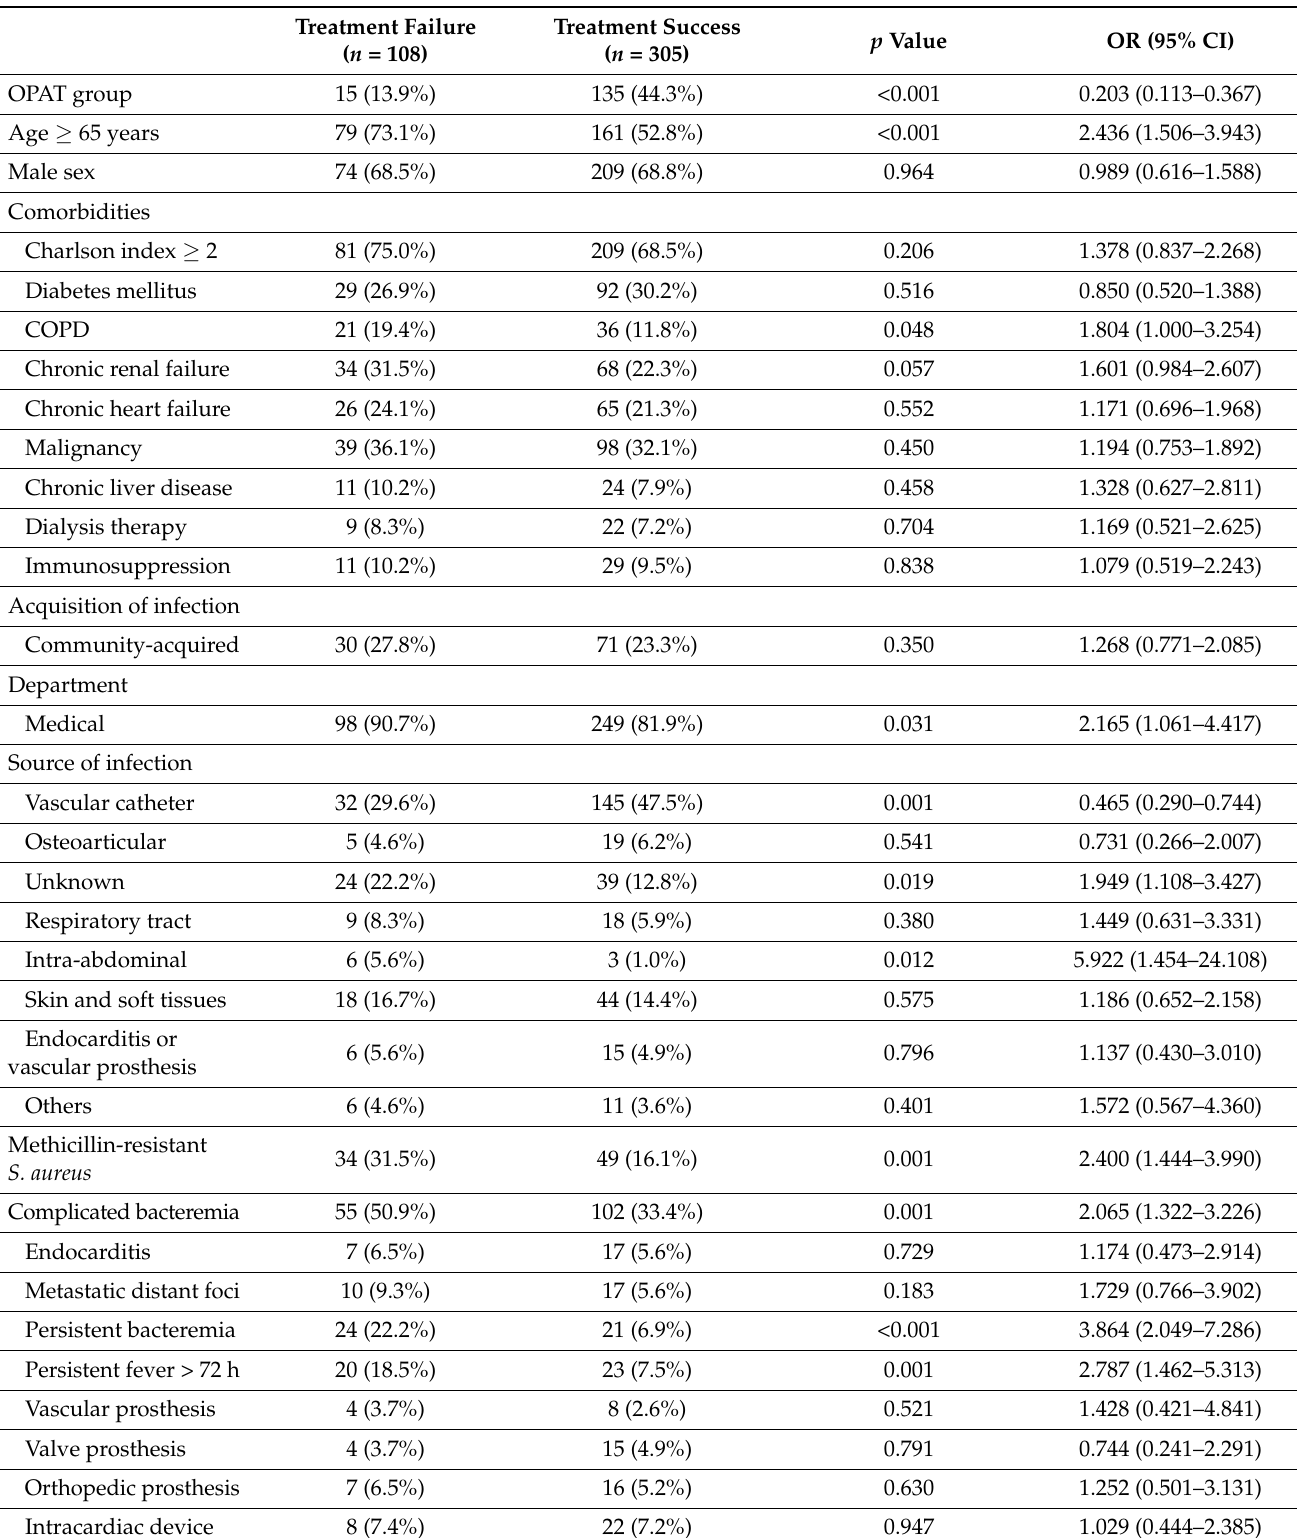
Table 2. Bivariate analysis of variables associated with 60-day treatment failure (including 60-day mortality and/or 60-day